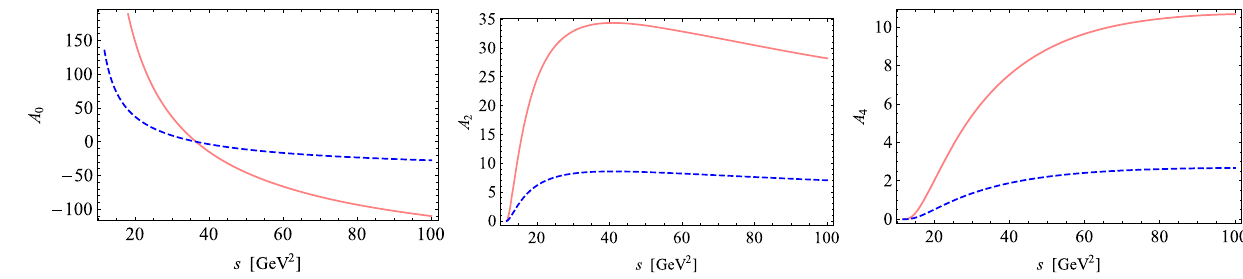
Fig. 1 The tree-level amplitudes S -, D -, and G -wave for two values of (cid:2) G (0 . 4GeV (pink, solid) to 0 . 8GeV (blue, dash), respectively). We remember that the amplitudes are purely real at this order